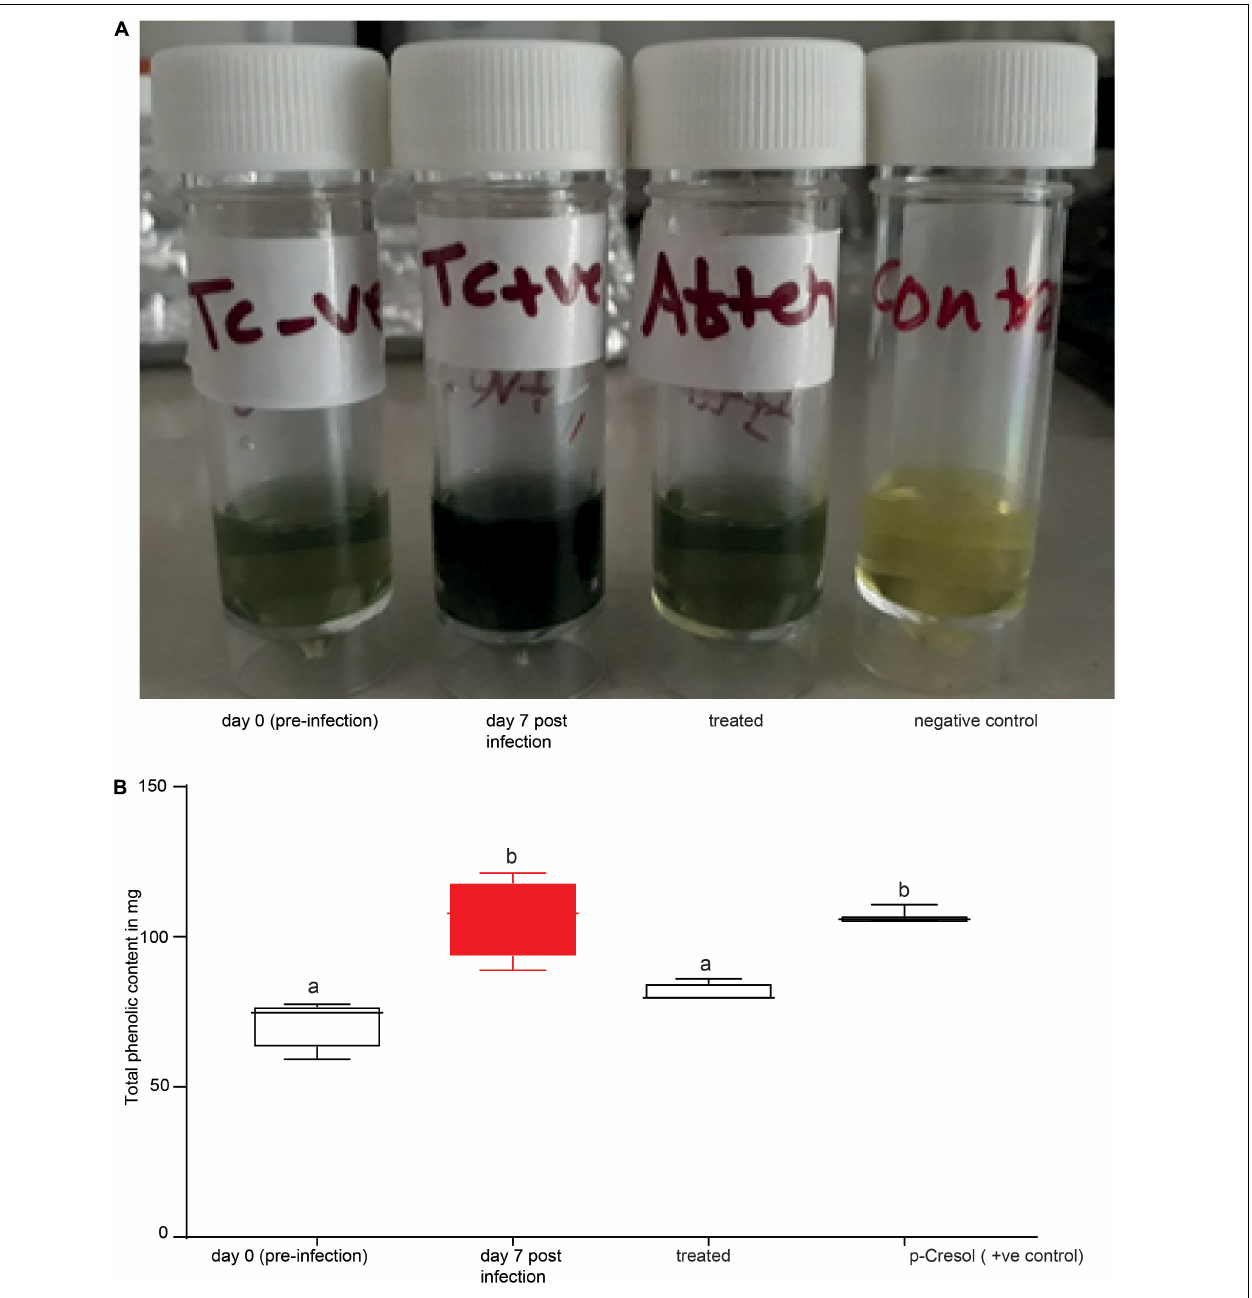
FIGURE 9 | Phenolic biomarkers can be used to diagnose animal trypanosomosis. (A) Shows the urine of the same cow before (day 0 pre-infection), during infection (day 7 post-infection) and after treatment. (B) Spectrophotometer data quantifying the total phenolic content in the urine of healthy, infected, treated cow (verbine) and 500 ng/ µ l p -cresol (positive control) as standard. Bars followed by different letters are statistically different, ANOVA followed by Tukeys Post hoc test, n = 4. Error bars represent standard error of the mean. Folin–Ciocalteu reagent upon reacting with phenolics, it produces a blue color which absorbs at 760 nm and the intensity increases linearly with the concentration of phenolics in the